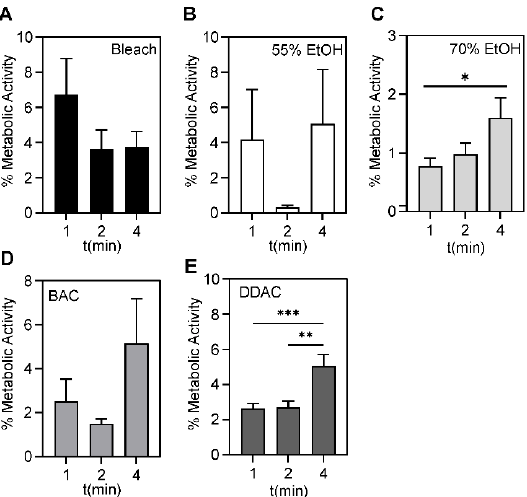
Figure 5. Bacterial biofilm survival following microbicide exposure. No significant differences were